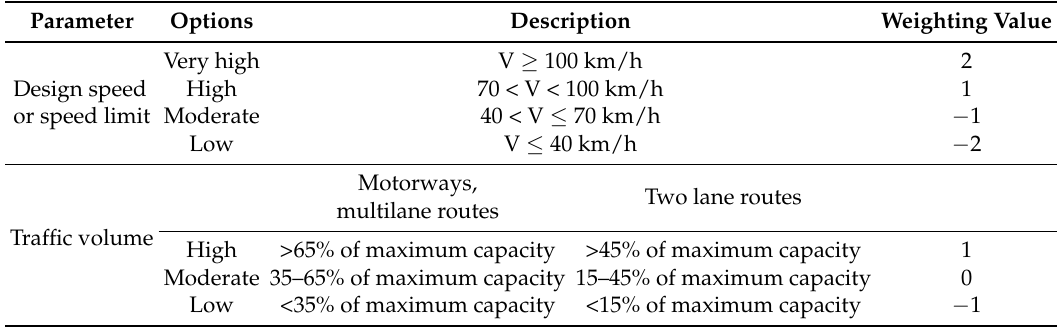
Table 1. Parameters for the selection of lighting class M (CEN/TR 13201 2014)